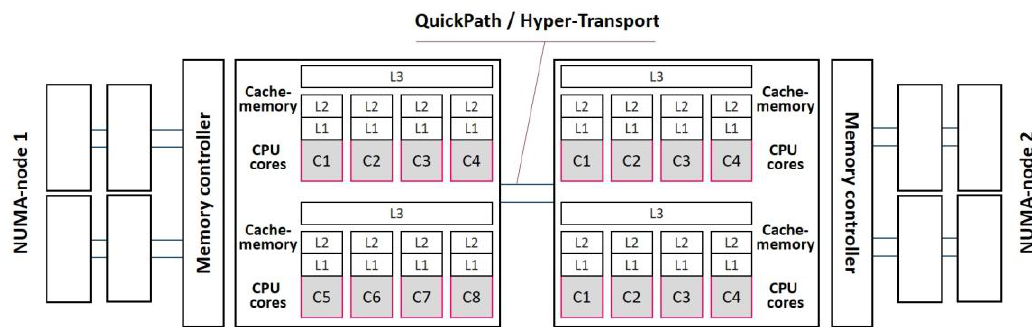
Figure 1. Structure of NUMA-systems.